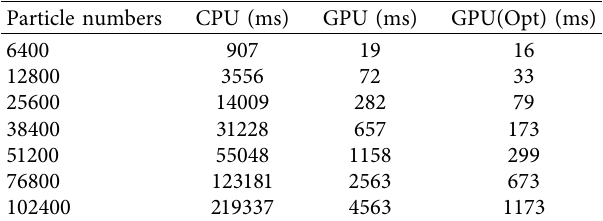
Table 3: Running time of CPU algorithm and GPU algorithm for single-atom average potential energy